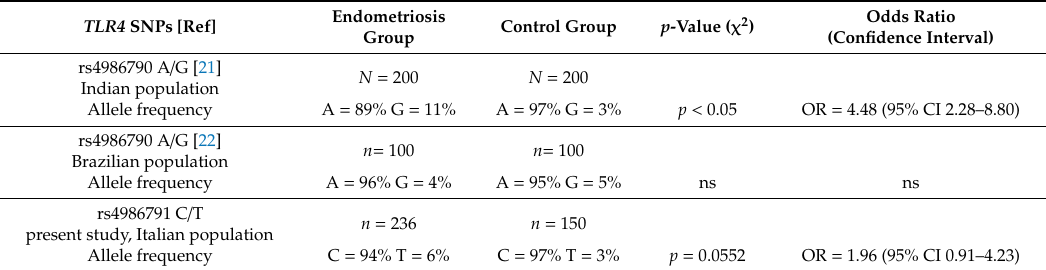
Table 3. TLR4 SNPs in endometriosis patients and controls in di ff erent